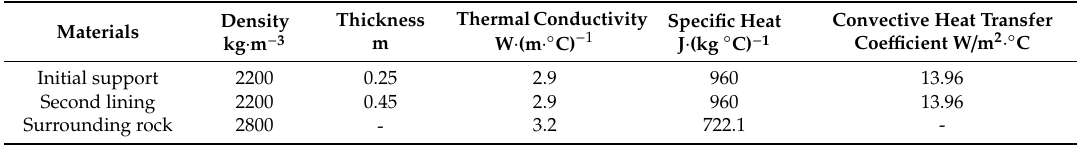
Table 1. Parameters of heat